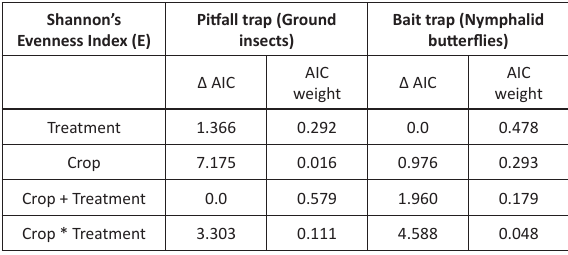
Table 2. Model selection results for factors affecting evenness of overall ground insects and nymphalid butterflies. The best model is included in boldface font.